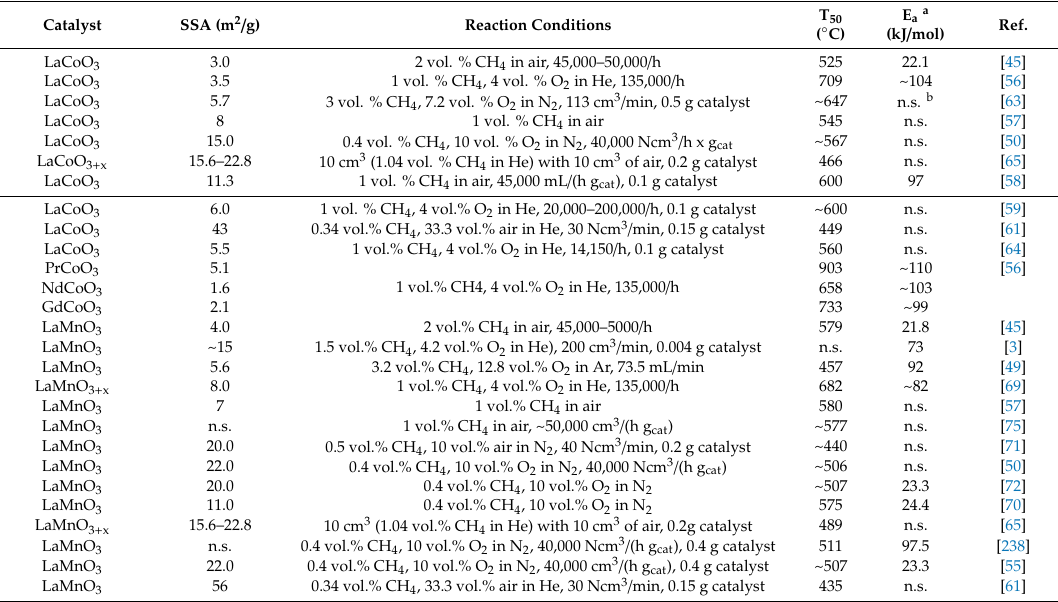
Table 9. Methane combustion activity of undoped perovskite-type materials expressed as the temperature where 50% conversion is reached (T 50